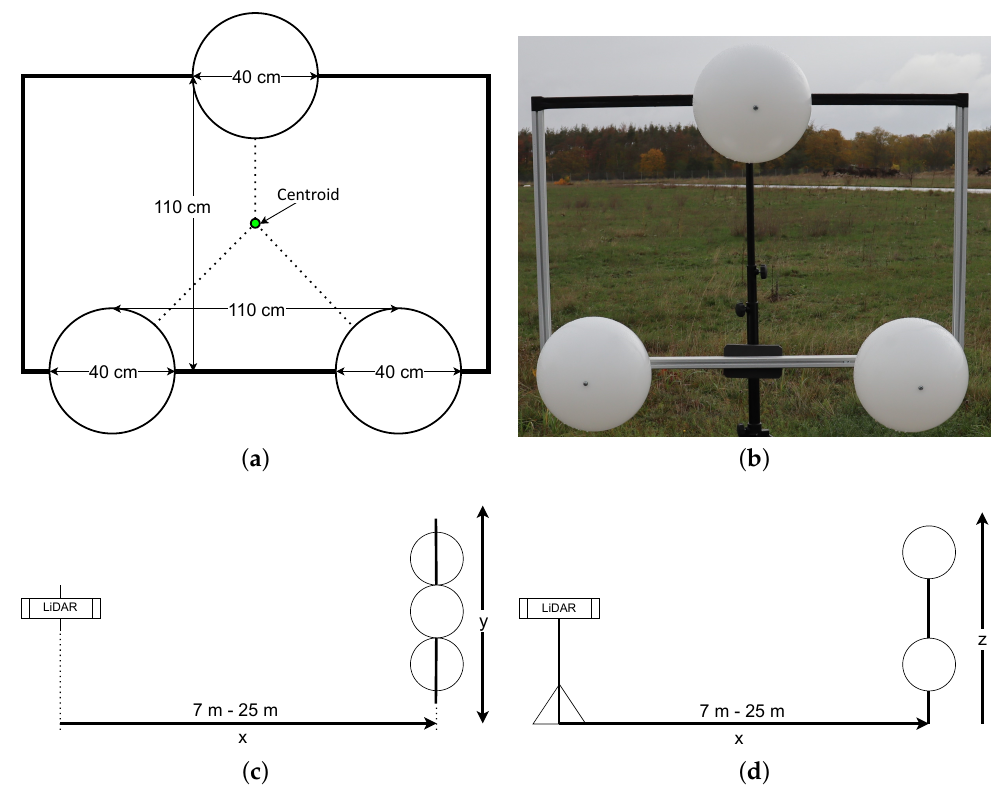
Figure 1. Scenario 1 setup: ( a ) Construction sketch. ( b ) Picture of the construction. ( c , d ) Topview and sideview of the measurement